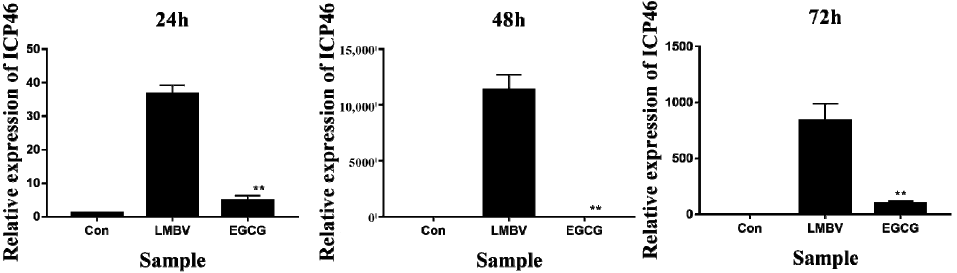
Figure 7. Antiviral activity of green tea component EGCG against LMBV in vivo. Largemouth bass were injected intraperitoneally with LMBV mixed with EGCG at its safe working concentration of 10 µ g/mL. Spleen tissues were analyzed for antiviral activity at 24, 48, and 72 hpi. ** indicates p <